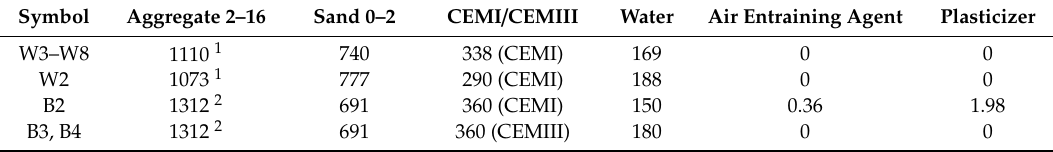
Table 2. Mixture proportions (kg / m 3 ).